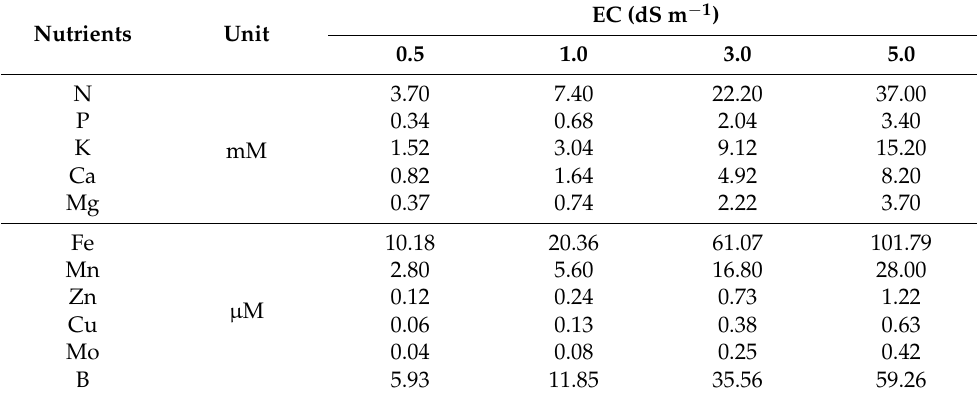
Table 1. Nutrient concentration of different EC